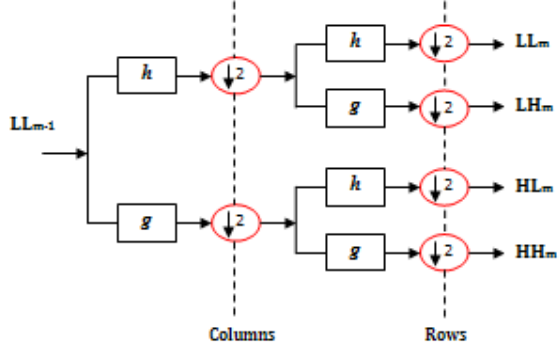
Figure 2. Decomposition filters bank for separable 2D- biorthogonal wavelet transform